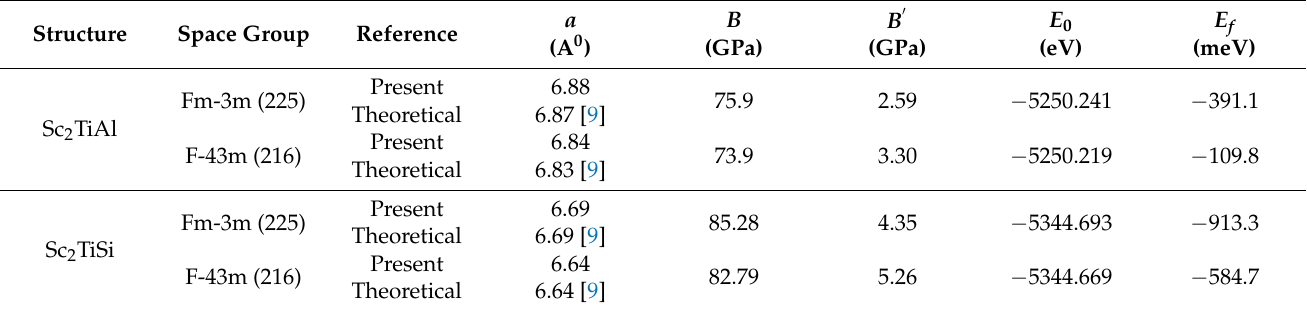
Table 1. The obtained la tt ice constant ( a ), bulk modulus ( B ), pressure derivative of the bulk modulus ( B ’), minimum energy ( E 0 ), and formation energy ( E f ) for the regular and inverse Heusler of both Sc 2 TiAl and Sc 2 TiSi.